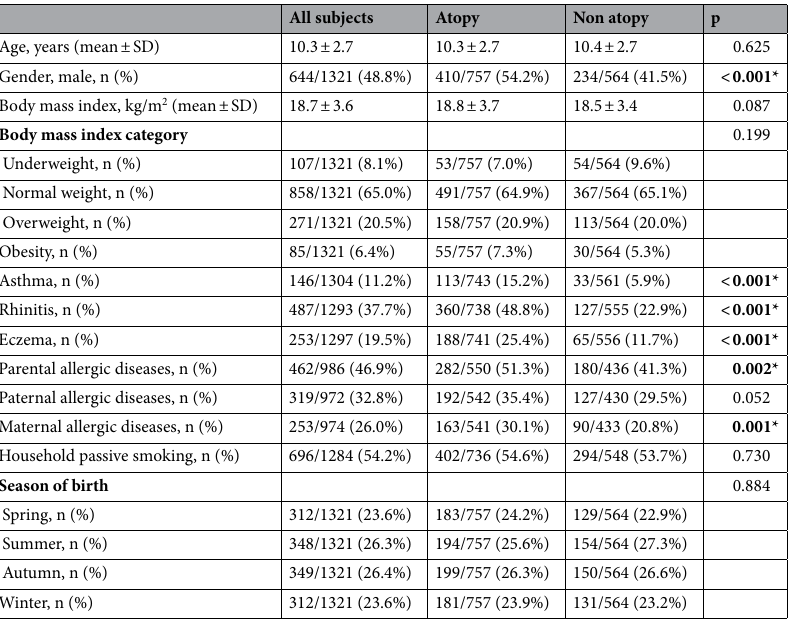
Table 1. Characteristics of study subjects. SD standard deviation. * P < 0.05 is